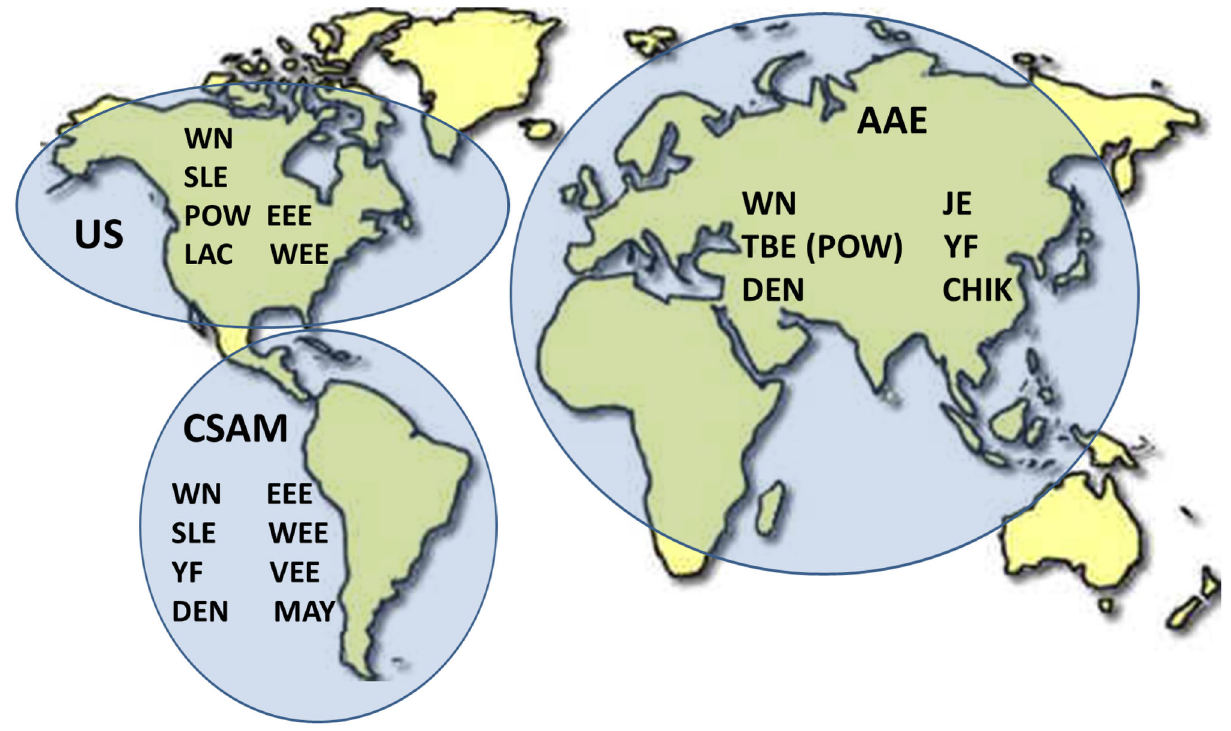
Figure 1. Map depicting the areas covered and viruses tested for in the 3 multiplex MIA geographic batteries. US covers the US and Canada; CSAM covers Central and South America and the Caribbean; AAE covers Asia, Europe and Africa. Australia and parts of the South Pacific are not included in the multiplex